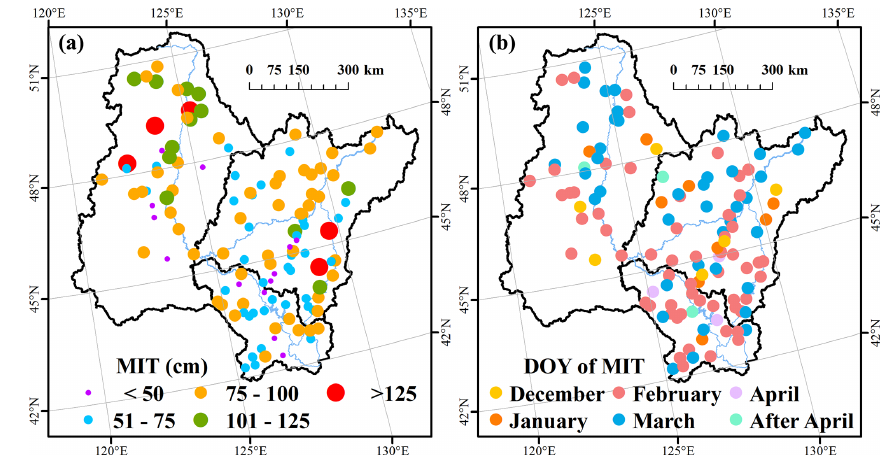
Figure 5. The spatial distribution of yearly maximum ice thickness (MIT) of the river center (a) and the corresponding date (b)